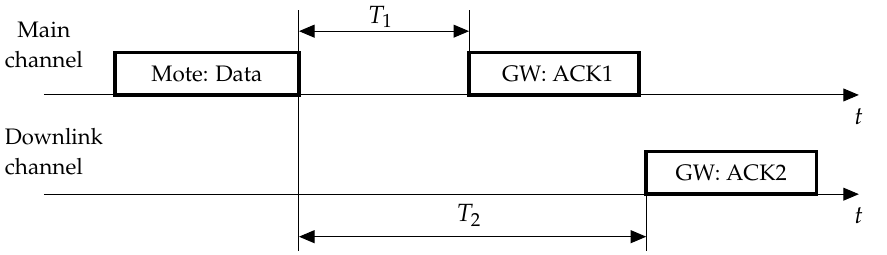
Figure 2. Data transmission and acknowledgment in a LoRaWAN